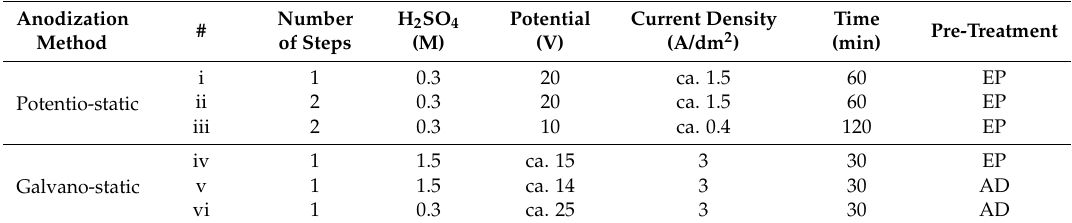
Table 2. Parameters of the APA samples prepared under the conditions listed in Table 1: D p (pore diameter), D c (cell diameter), t (oxide film thickness), n (pore density), and S p (inner pore surface area per 1 cm 2 of APA surface).